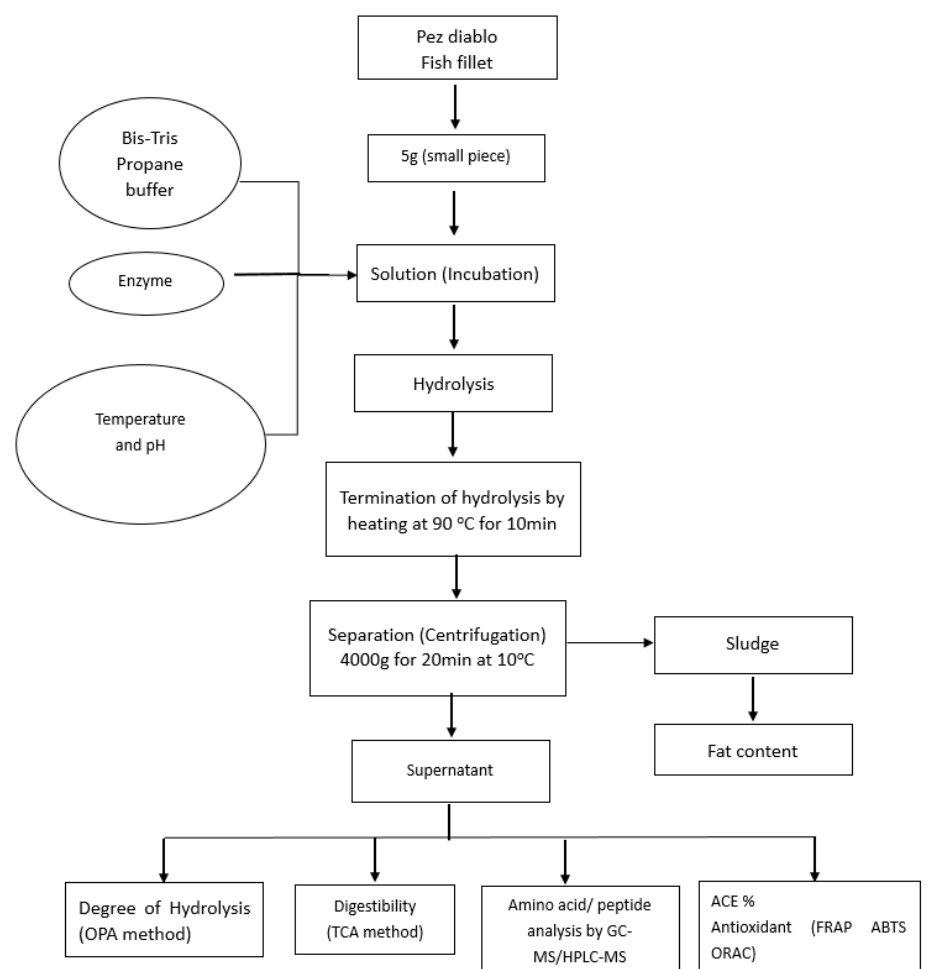
Figure 6. Process followed for the preparation of Pterygoplichthys disjunctivus hydrolysates. Table 2. Conditions for each of the